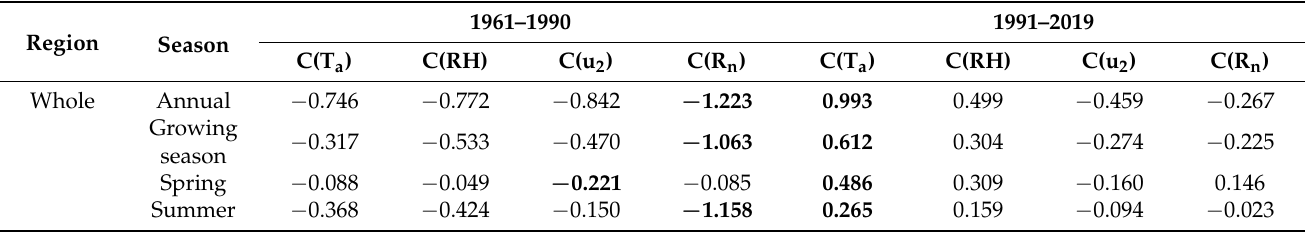
Figure 9. Contributions of meteorological factors to ET 0 trends during 1961–1990 and 1991–2019.